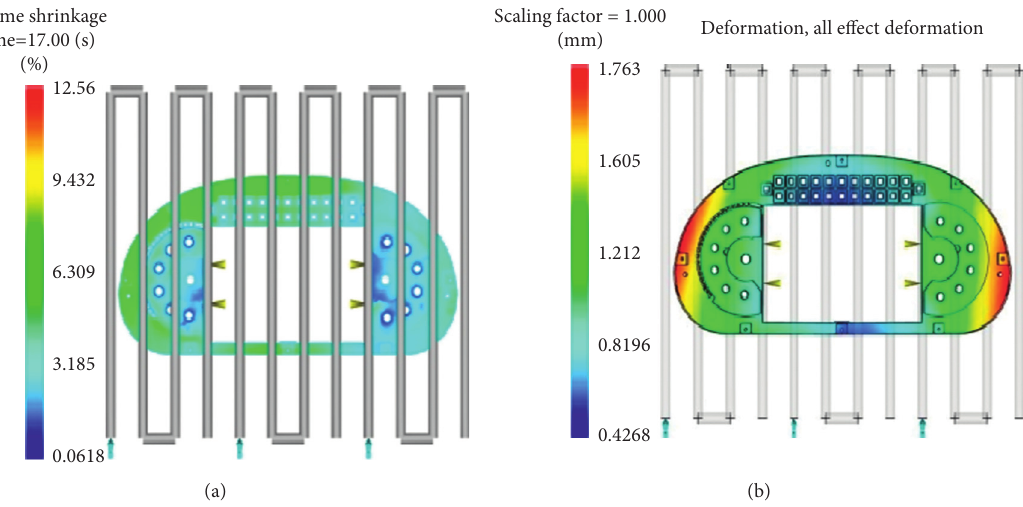
Figure 11: Analysis results for A 4 B 4 C 1 D 4 E 1